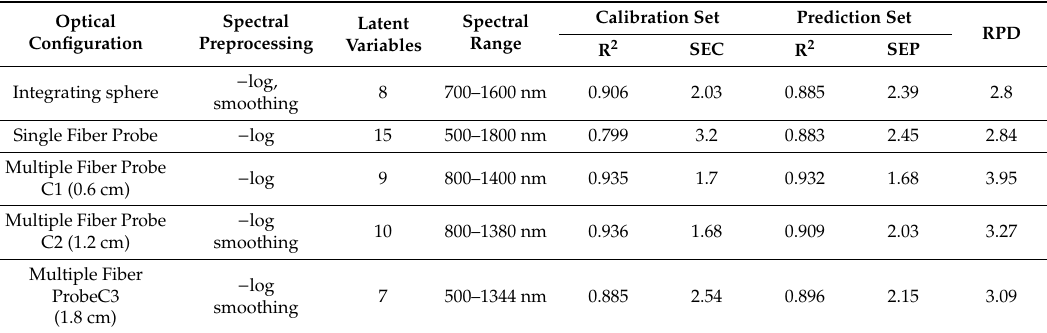
Table 2. Figure of merit of the calibration and prediction using the di ff erent optical